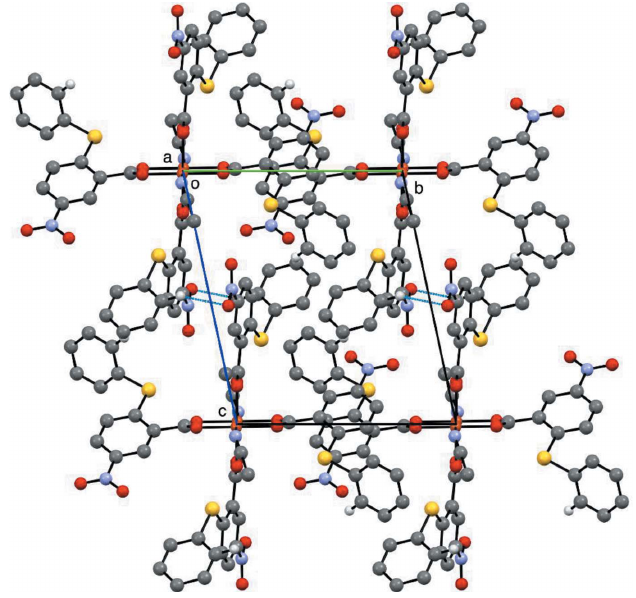
Figure 2 Packing of the molecules in the title compound, with intermolecular C—